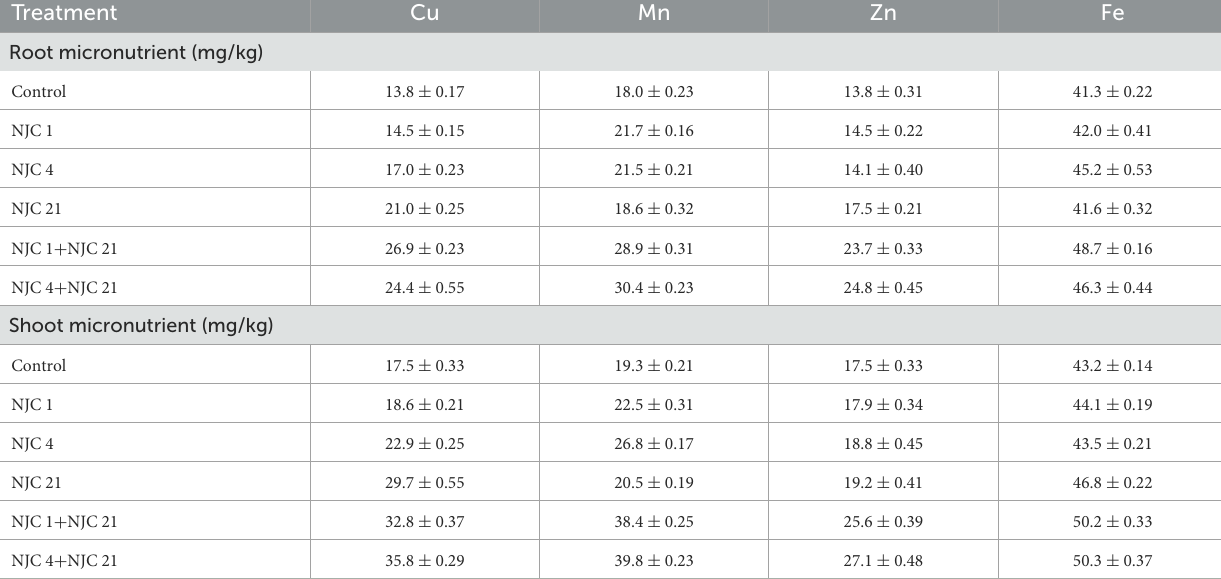
TABLE 4 Micronutrient analysis of roots and shoots after the pot experiment from each treatment.